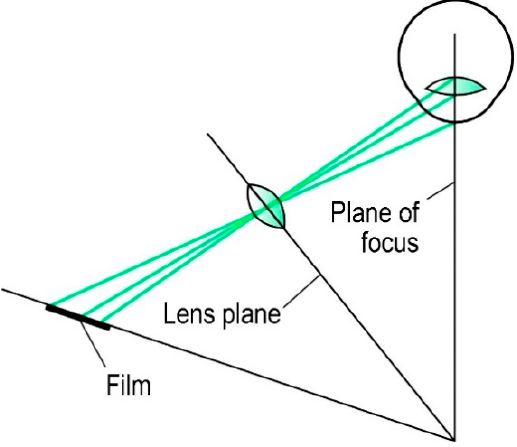
Figure 13. Principle of Scheimpflug imaging [90].